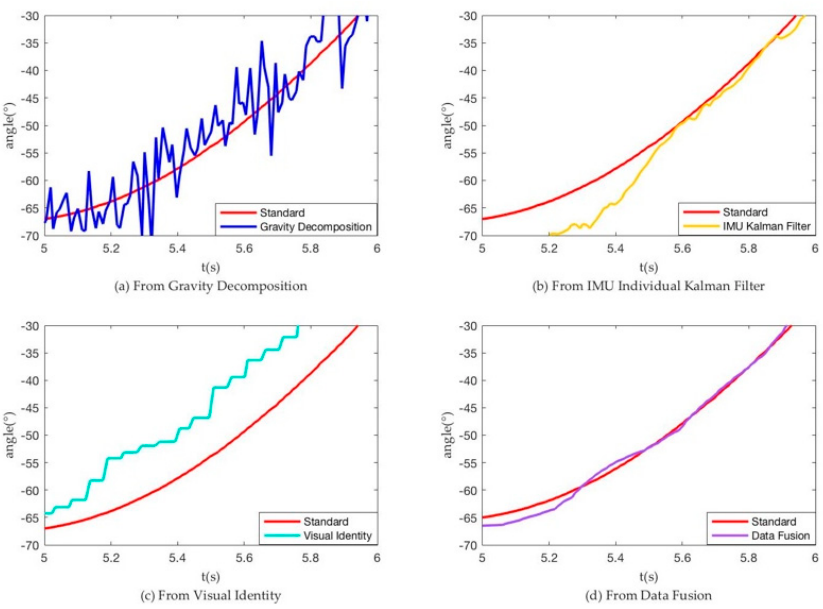
Figure 11. Partial enlarged drawing of Figure 10 (Between 4th and 5th second).